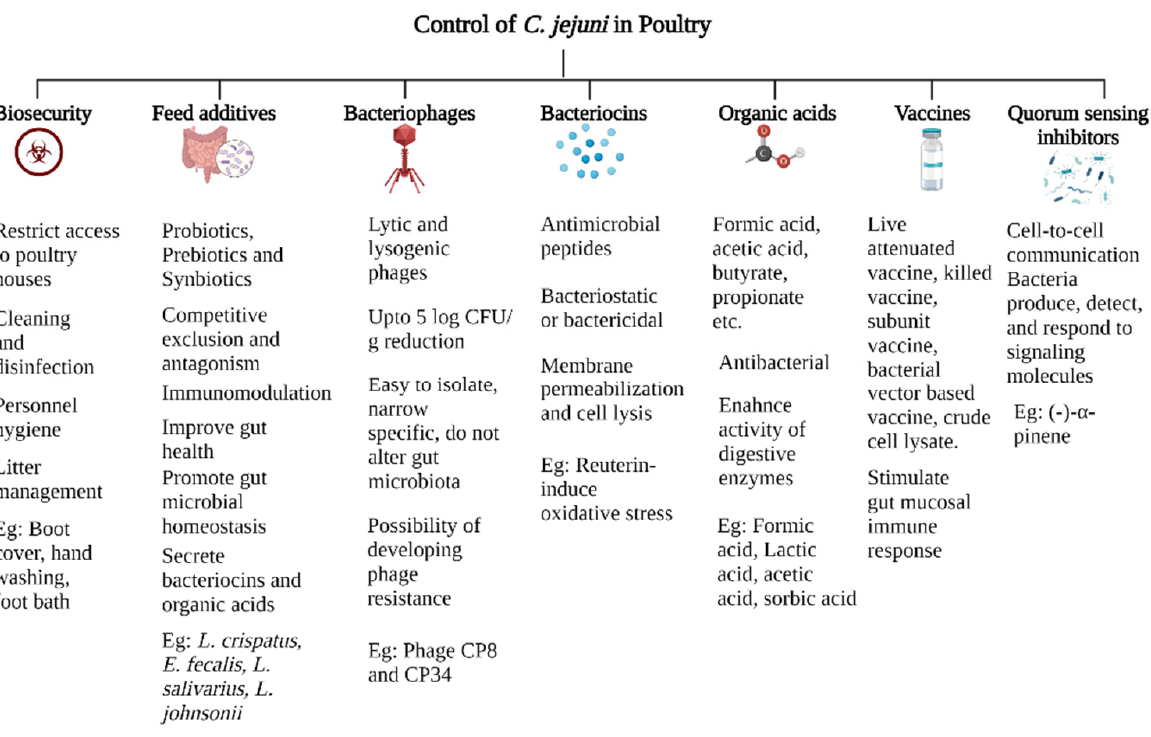
Figure 3. Control strategies of C. jejuni in poultry. Created with Biorender.com (accessed on 20 October 2022).